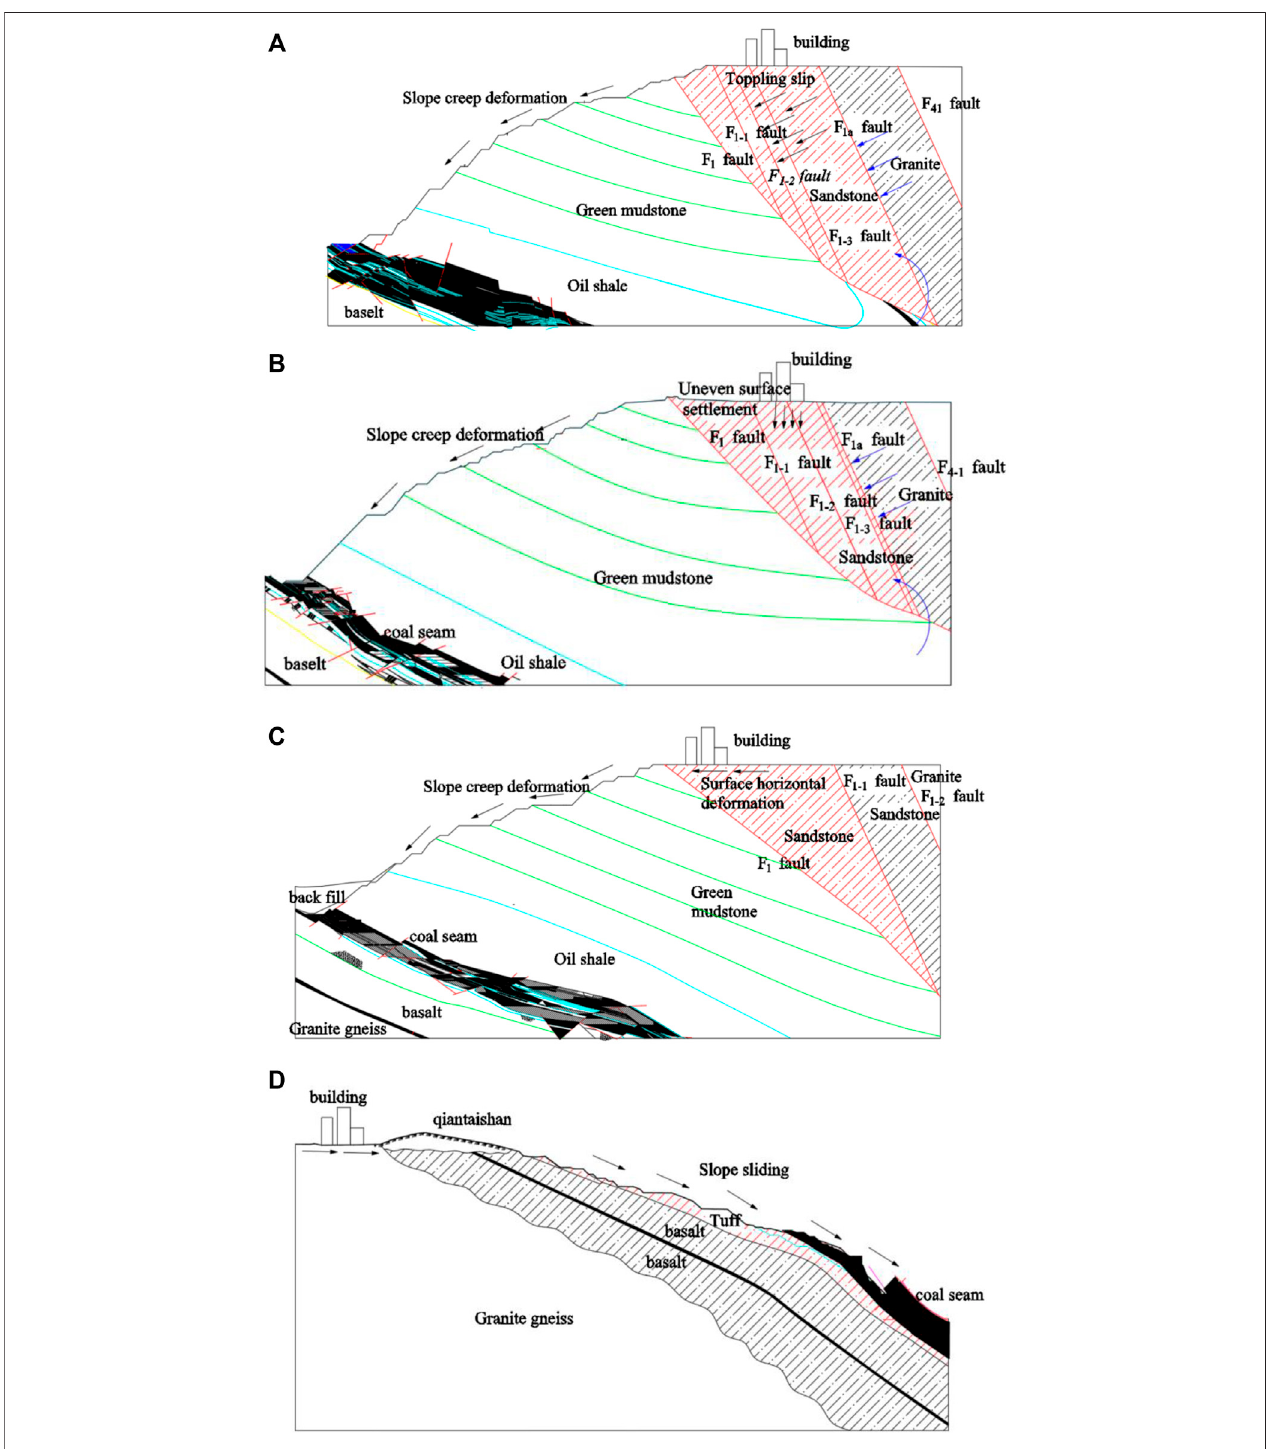
FIGURE 4 | Sliding deformation mechanism of slopes in each feature zone: (A) feature-1 Zone Wedge Rotating Slip; (B) feature-2 Zone Wedge Dumping Slip; (C) feature-3 zone Wedge Flush Slip; (D) feature-3 area south gang slope body downward sliding.